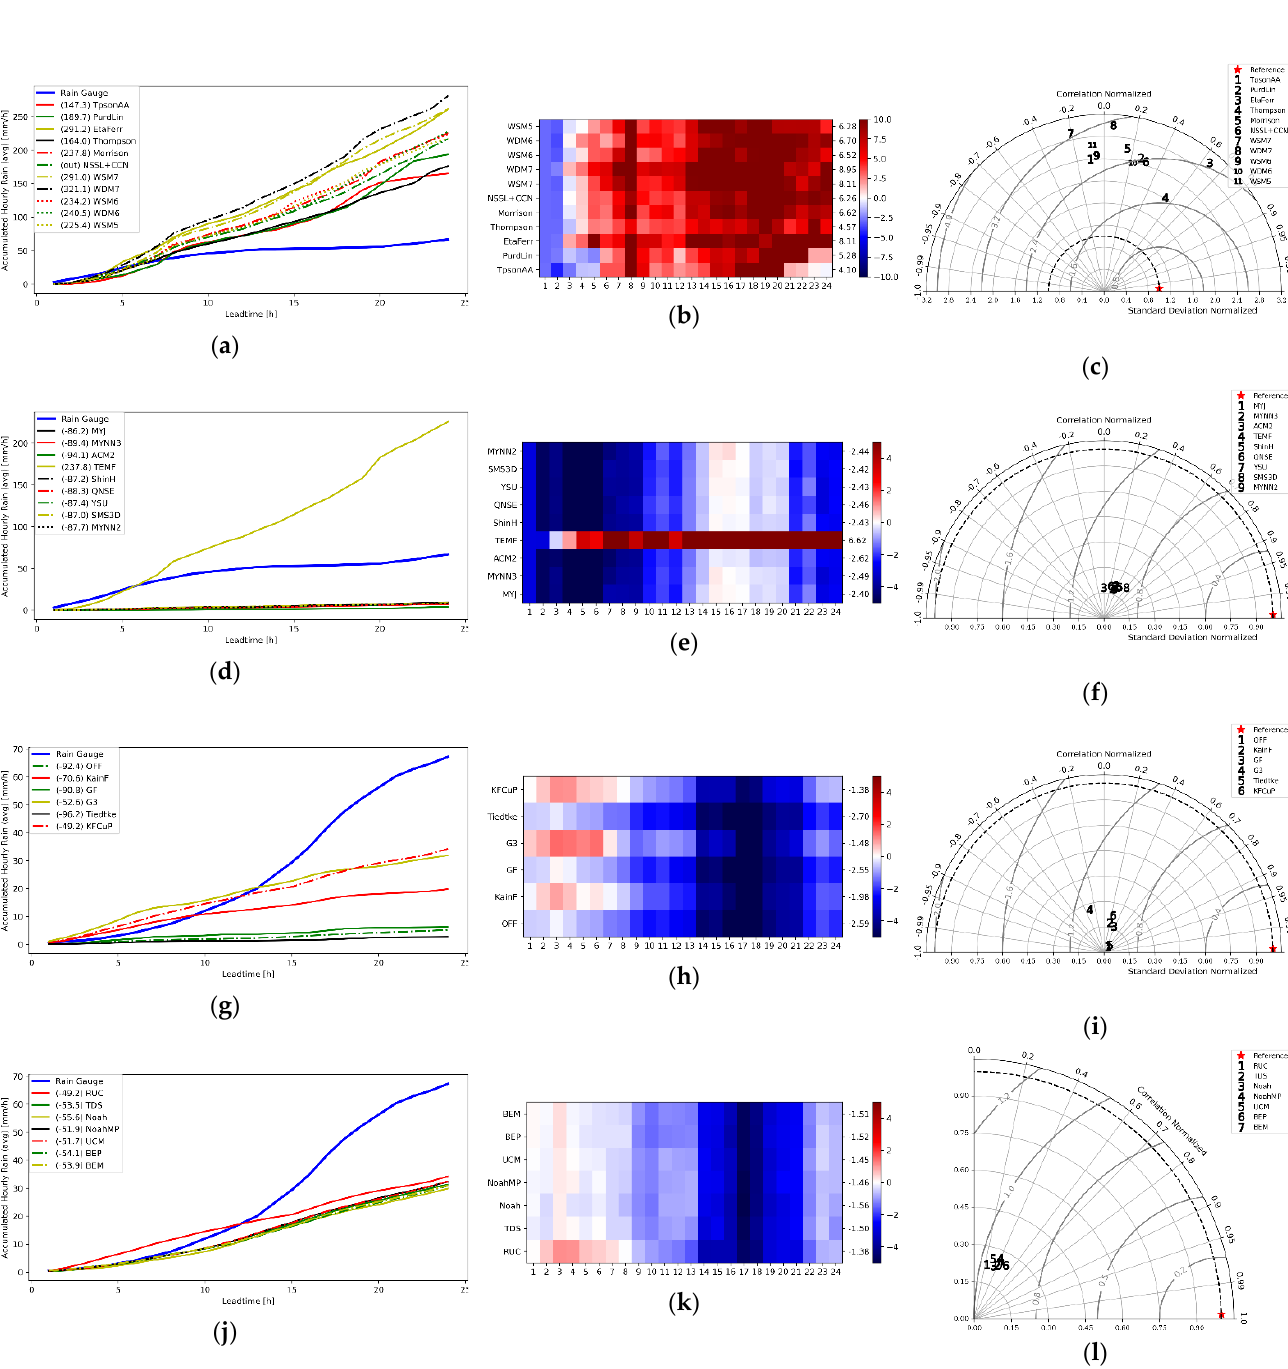
Figure 4. Analysis of the model settings for event 1: ( a − c ) microphysics settings, ( d − f ) the planetary boundary layer, ( g − i ) cumulus, and ( j − l ) surface parameterizations. The column on the left compares the average hourly accumulated rainfall at the rain gauges with the rainfall generated by the model according to the settings under analysis; inside the legend are the relative errors (REs) accumulated over 24 h for each configuration. The middle column shows the average hourly bias and on the secondary axis the average period bias. The column on the right shows the Taylor diagram.